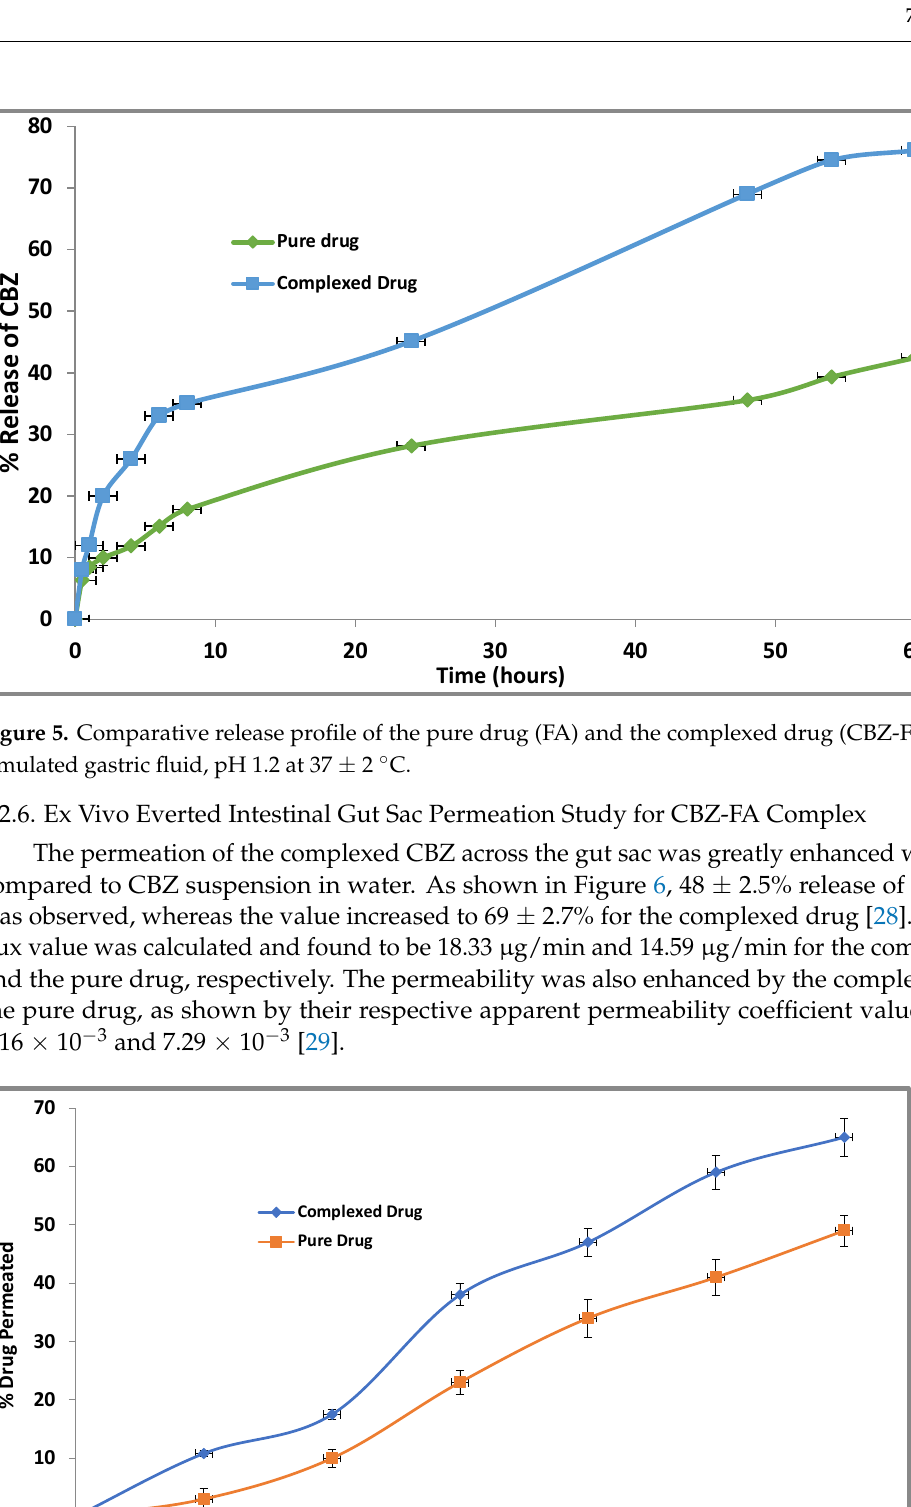
Table 2. The in vivo pharmacokinetic parameters of pure CBZ and complexed CBZ following oral administration in rats. Parameters